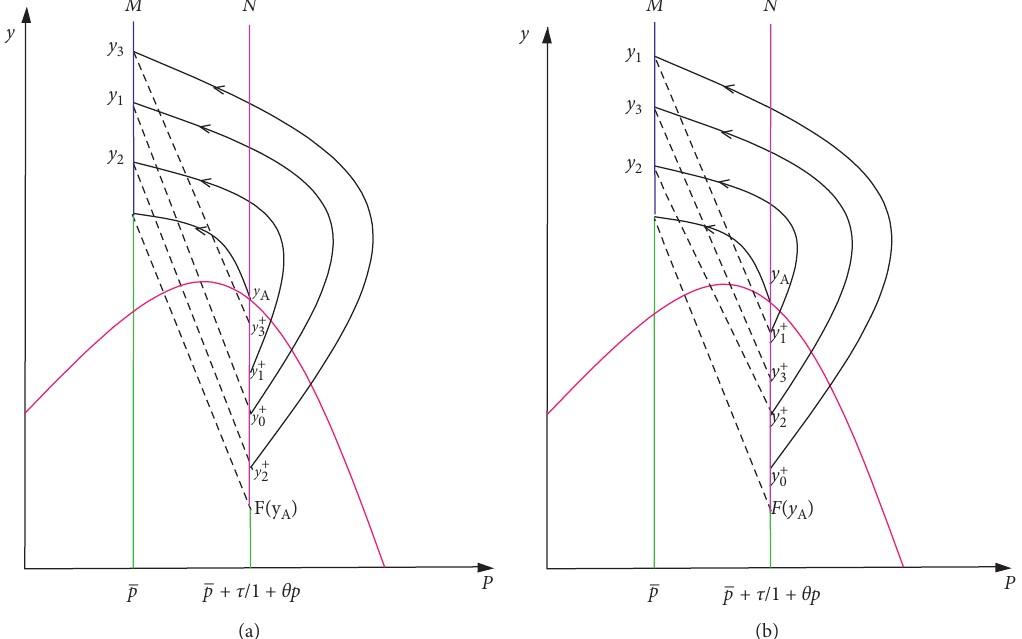
Figure 4: Path curve of system (7). (a) y